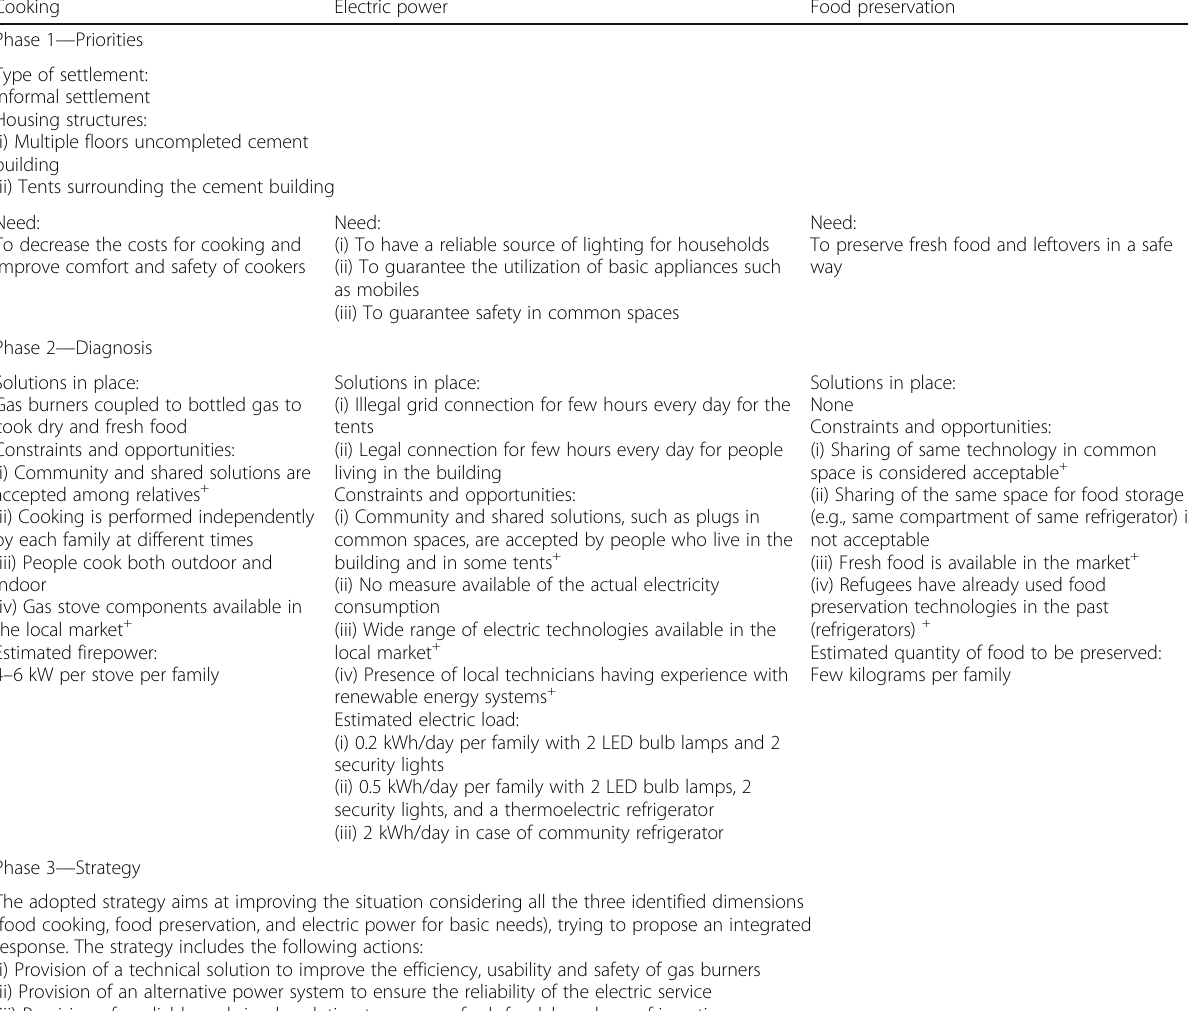
Table 1 Proposed methodology applied to a settlement in Lebanon Cooking Electric power Food